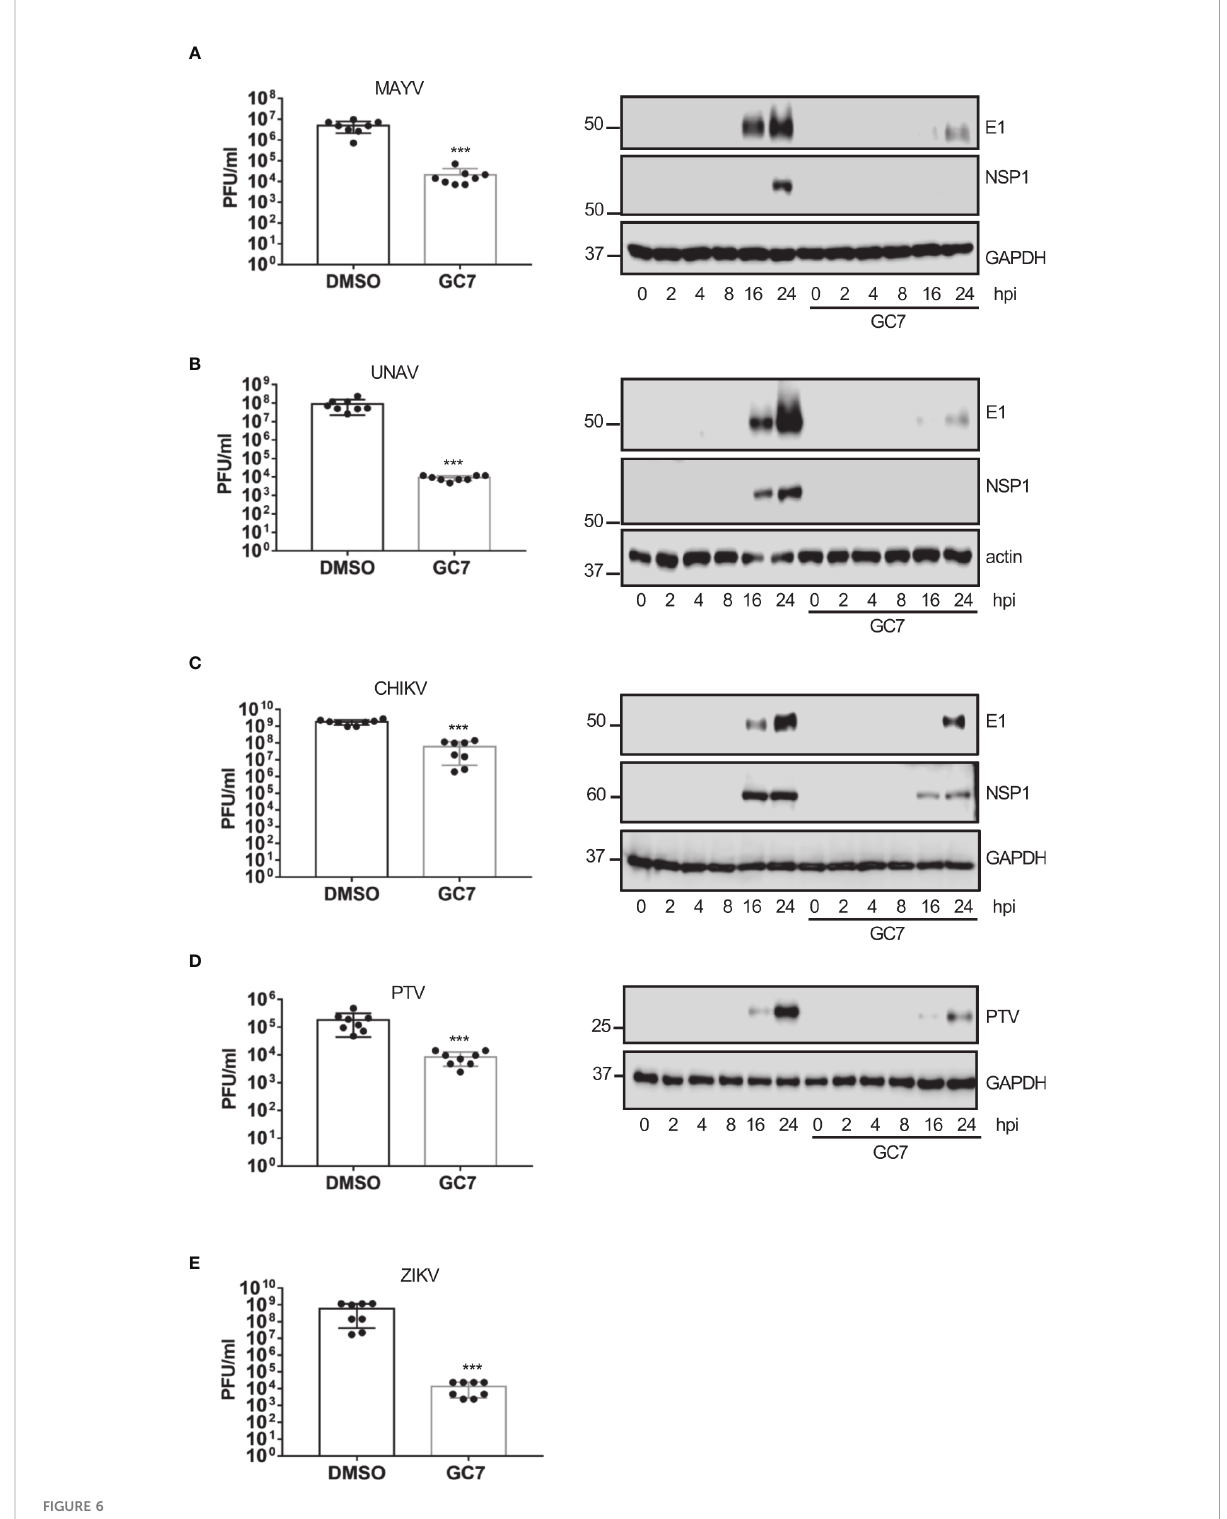
FIGURE 6 Effect of eIF5A activation on Alphavirus, Flavivirus and Phlebovirus replication. Effect of hypusine inhibition on (A) mayaro virus (MAYV) replication (left panel) or E1 and NSP1 viral protein synthesis (right panel), (B) una virus (UNAV) replication (left panel) or E1 and NSP1 viral protein synthesis (right panel), (C) chikungunya virus (CHIKV) replication, (D) punta toro virus (PTV) replication and protein synthesis, and (E) zika virus (ZIKV) replication. Bar graphs represent the mean and error bars of eight biological replicates (the experiment was repeated twice and in each experiment, 4 independent samples per treatment type were measured). Statistical analysis was assessed by a Student ’ s t-test. ***,